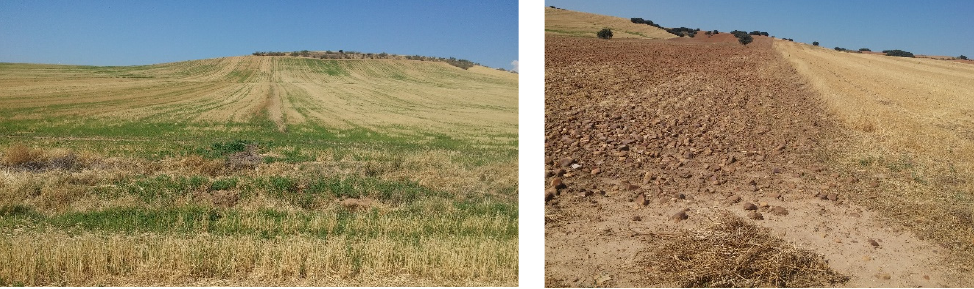
Image 4: Difference between bare soil after tilling (red zones—erosion) and covered by remnants of cereal crops (yellow zones—no erosion)